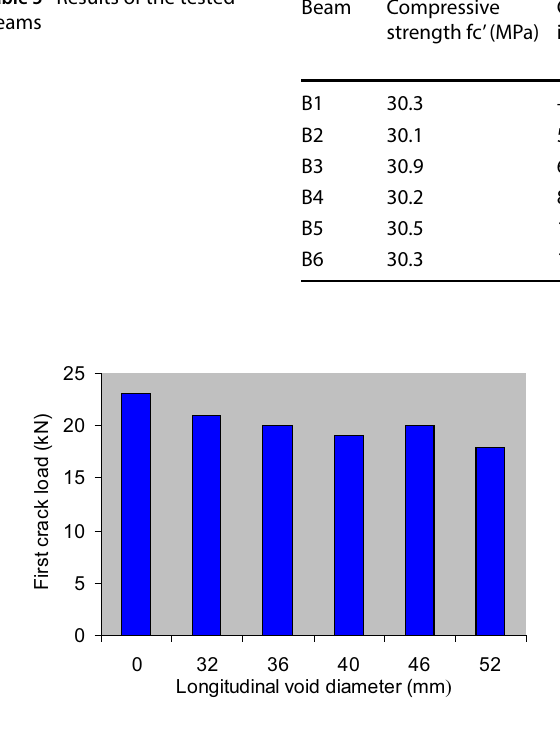
Table 5 Results of the tested beams